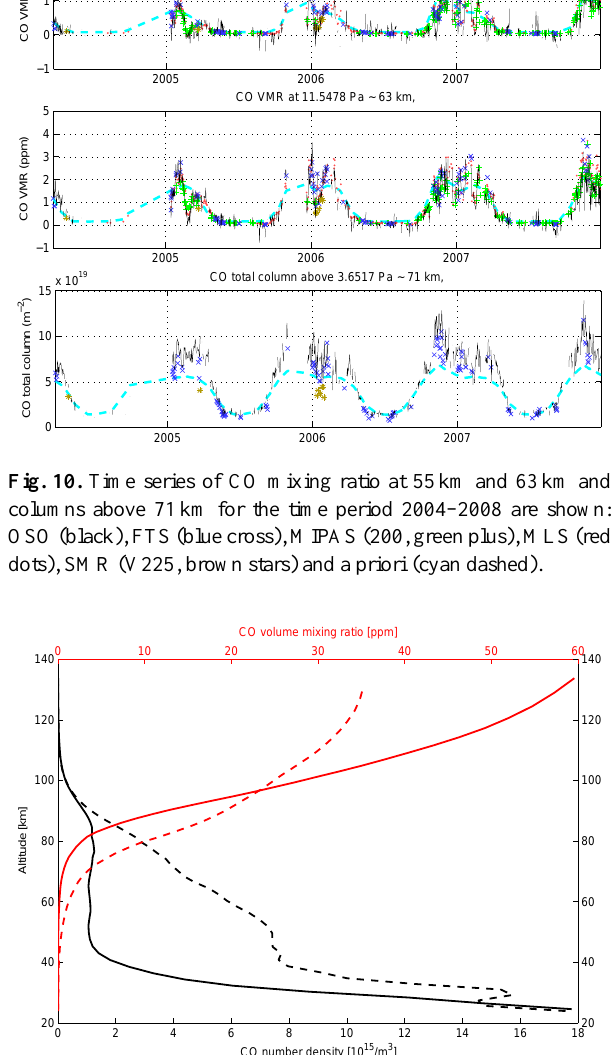
0 Fig. 11. The number density of CO (black) and the volume mixing ratio of CO (red) versus altitude. The data shown are the mean sum- mer (solid) and mean winter (dashed) OSO a priori from WACCM. The main contribution to the column above 70km originates from altitudes ≤ 100km